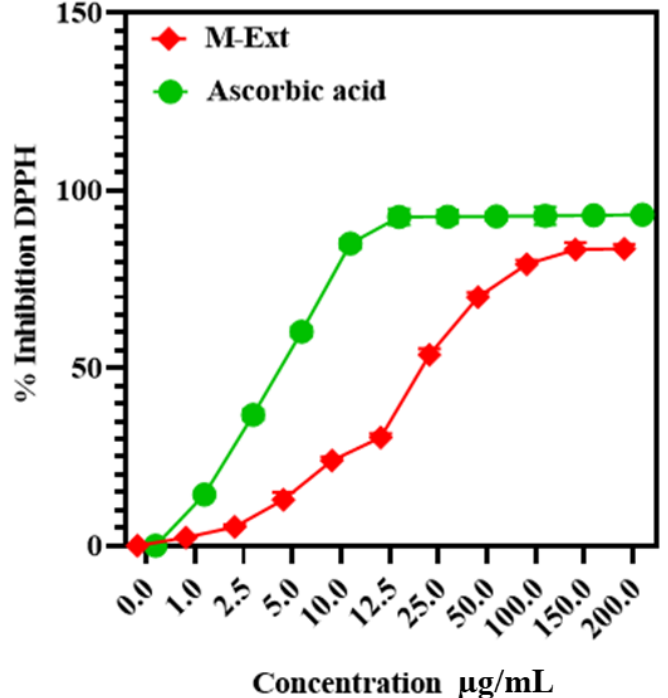
Figure 4. IC 50 of ascorbic acid and M-Ext (extract of mango peels and kernel). Data shown as means ± SD ( n = 3).